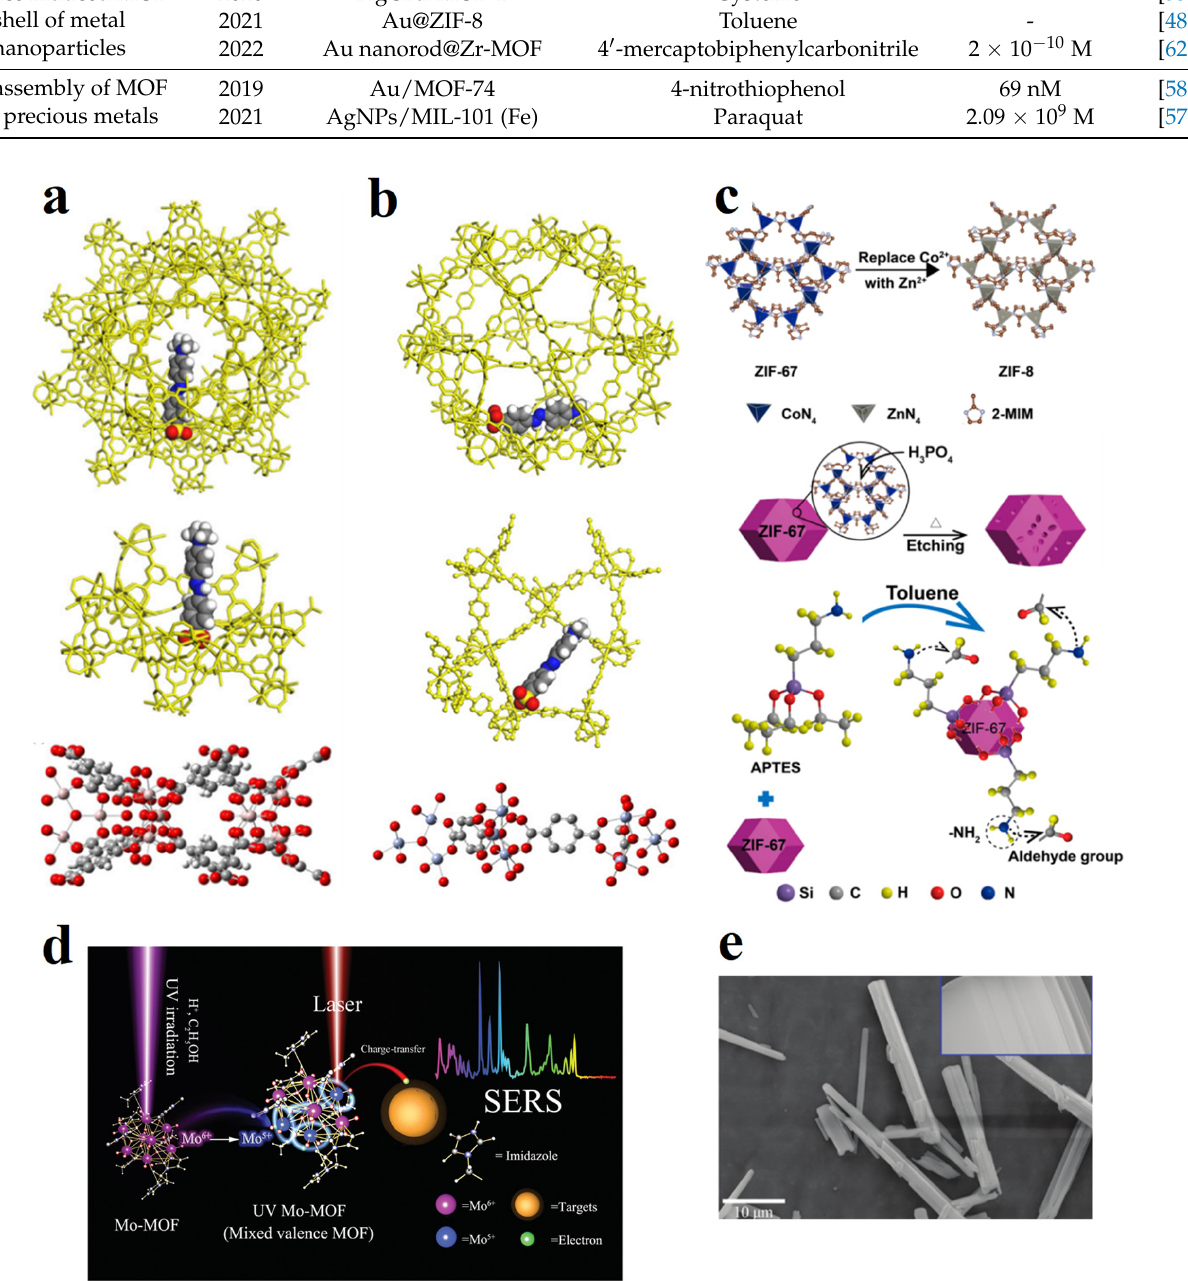
Figure 2. Single MOF as SERS substrate and semiconductor combined with MOF as SERS substrate ( a ) The molecular adsorption orientation of methyl orange in the MO+MIL-100 system is almost perpendicular to the bottom pentagonal ring [36]; ( b ) The molecular adsorption orientation of methyl orange in the MO+MIL-101 system is close to the bottom pentagonal ring [36]; ( c ) Metal ion replacement, optimization of phosphoric acid etching pore structure and surface modification [32]; ( d ) Synthesis of ultraviolet Mo-MOF and its SERS effect [59]; ( e ) SEM image of Mo-MOF [59].